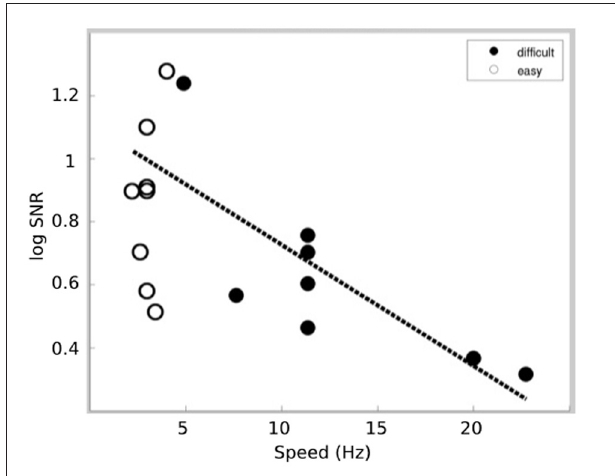
FIGURE 4 | SSAEP responses for each subject as a function of the speed. The responses for the difficult task are indicated by the filled circles while responses for the easy task are indicated by the empty circles. In general, we find that reduced SSAEP responses correspond to increasing speed (i.e., difficulty) in the visuospatial task. The dotted line indicates the linear fit to the data within the difficult